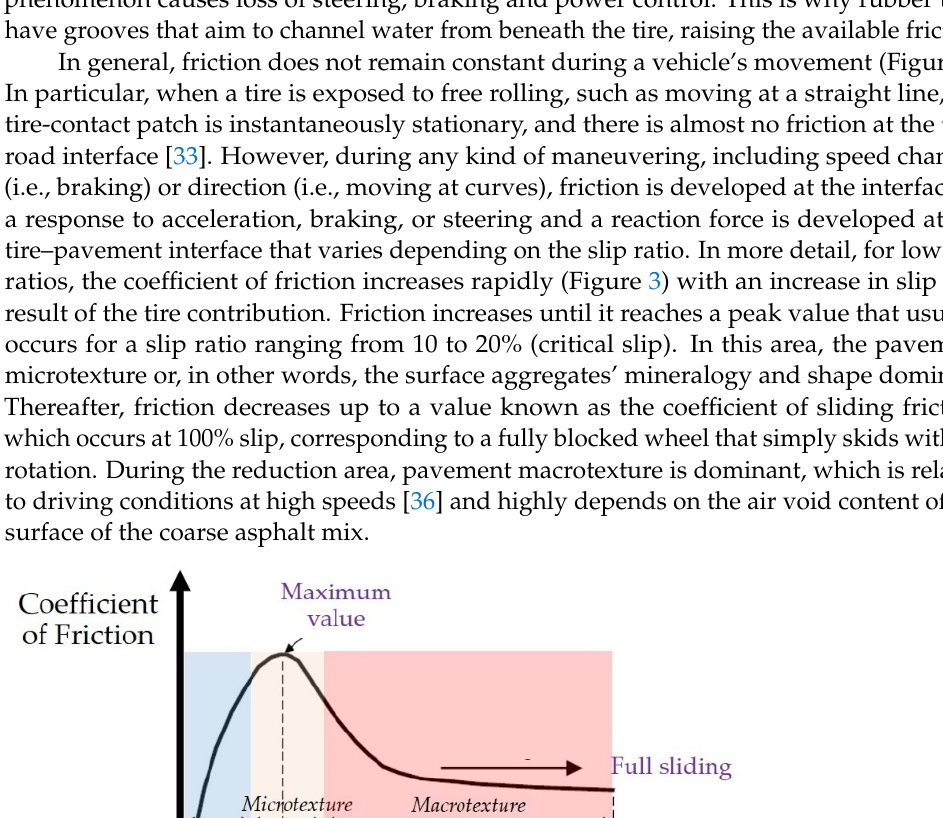
4 Figure 2. Friction circle during vehicle typical maneuvering [32]. While a vehicle is braking, which is the most crucial interaction between the road